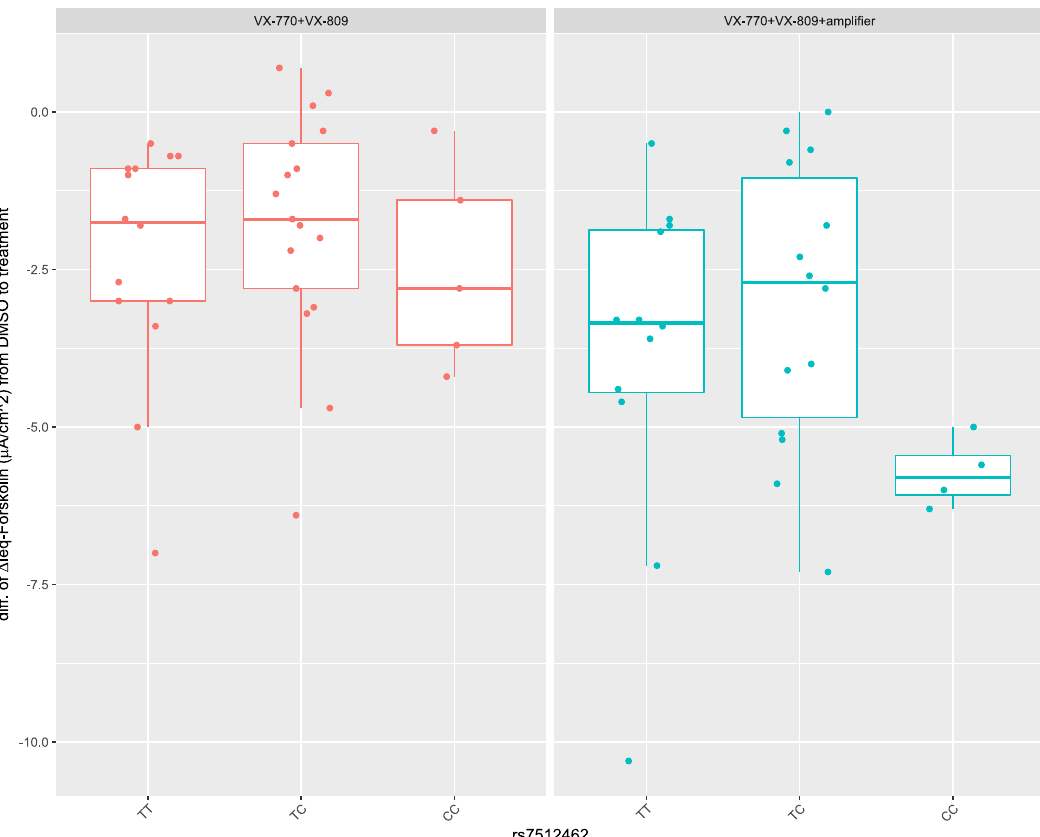
Fig. 3 Boxplot overlayed with stripchart for CFTR function by rs7512462 genotype in HNE cultured to P2. The CFTR function is de fi ned as the difference in Δ Ieq-forskolin from treatment with VX-770 + VX-809 (left; n = 36) or VX-770 + VX-809 + ampli fi er (right; n = 30) to DMSO vehicle in CFTR-mediated current in cultured HNE from participants homozygous for Phe508del. More negative measurements re fl ect greater CFTR function. The centerline, upper and lower box limits of boxplots correspond to the median, the third quartile (Q3) and the fi rst quartiles (Q1), respectively; whiskers re fl ect the 1.5x interquartile range (IQR), i.e., bottom whisker is Q1-1.5xIQR and upper whisker is Q3 + 1.5 x IQR. Each dot represents an individual measurement.